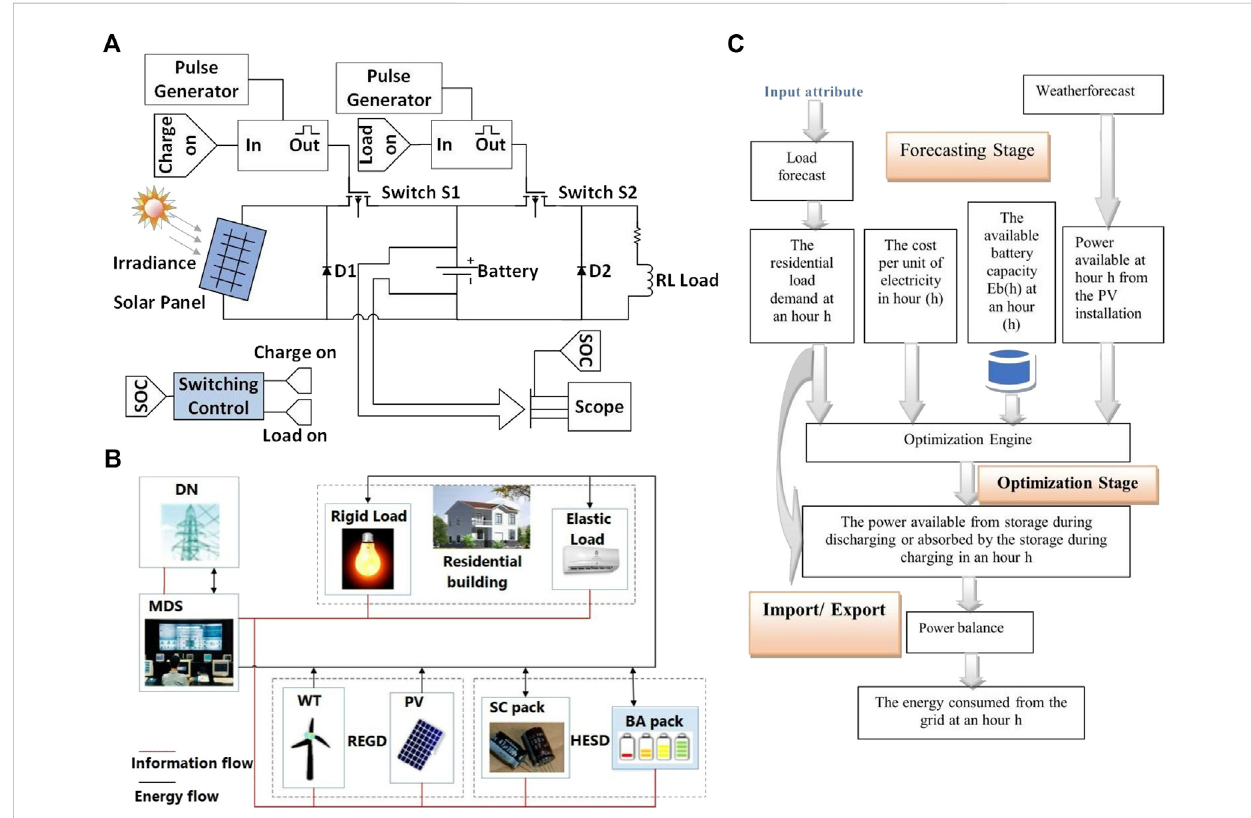
FIGURE 5 General-topologydiagramfor (A) buck-boostconverter-basedchargecontroller. (B) Energydispatchschedulingofgrid-connectedsolarPVsystem with battery storage (Jing et al., 2022). (C) Ideal charging and discharging schedule for a hybrid PV-battery system (Kapoor and Sharma,